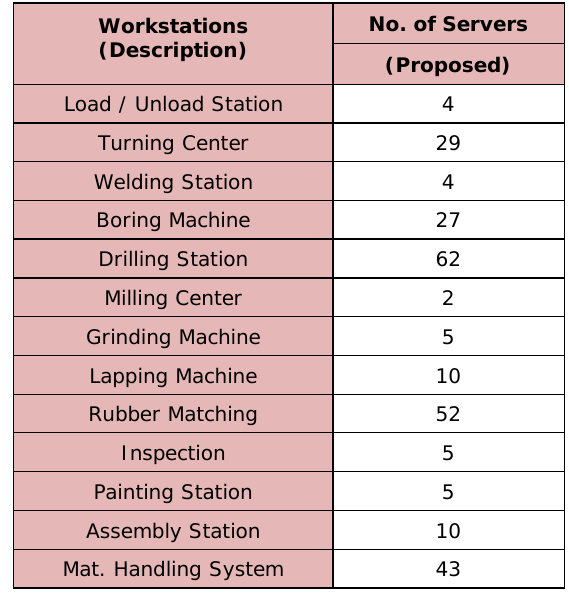
Table 5. “No. of Servers in Proposed FMS”. Source: Own